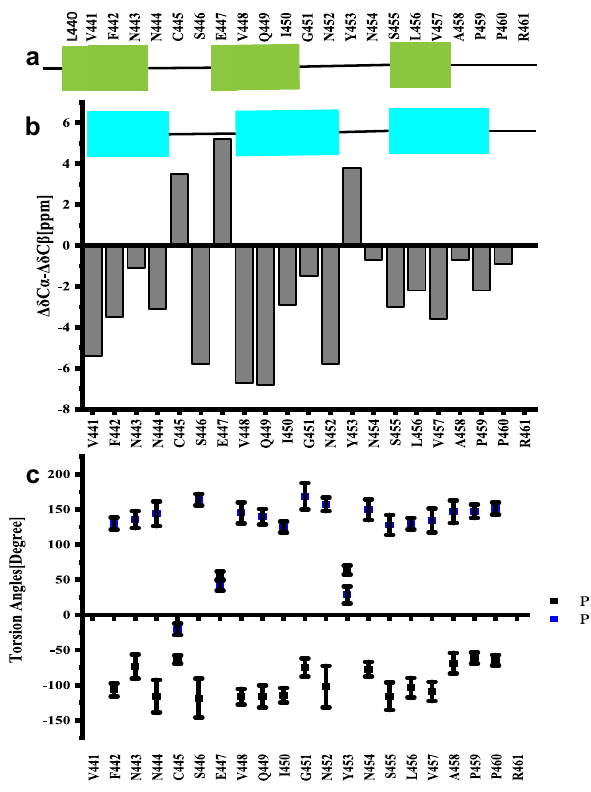
Fig. 4 Secondary structure prediction from the assigned chemical shifts. a Secondary structure prediction of mouse RIPK3 construct with PSIPRED 19 . b Plot of the difference in the secondary chemical shift between C α and C β , a negative value indicative of β -sheet secondary structures. c Predicted protein dihedral angles φ and ψ using TALOS-N based on SSNMR chemical shifts. Data are presented as mean values ± SD from predicted dihedral angles φ and ψ values of 25 best